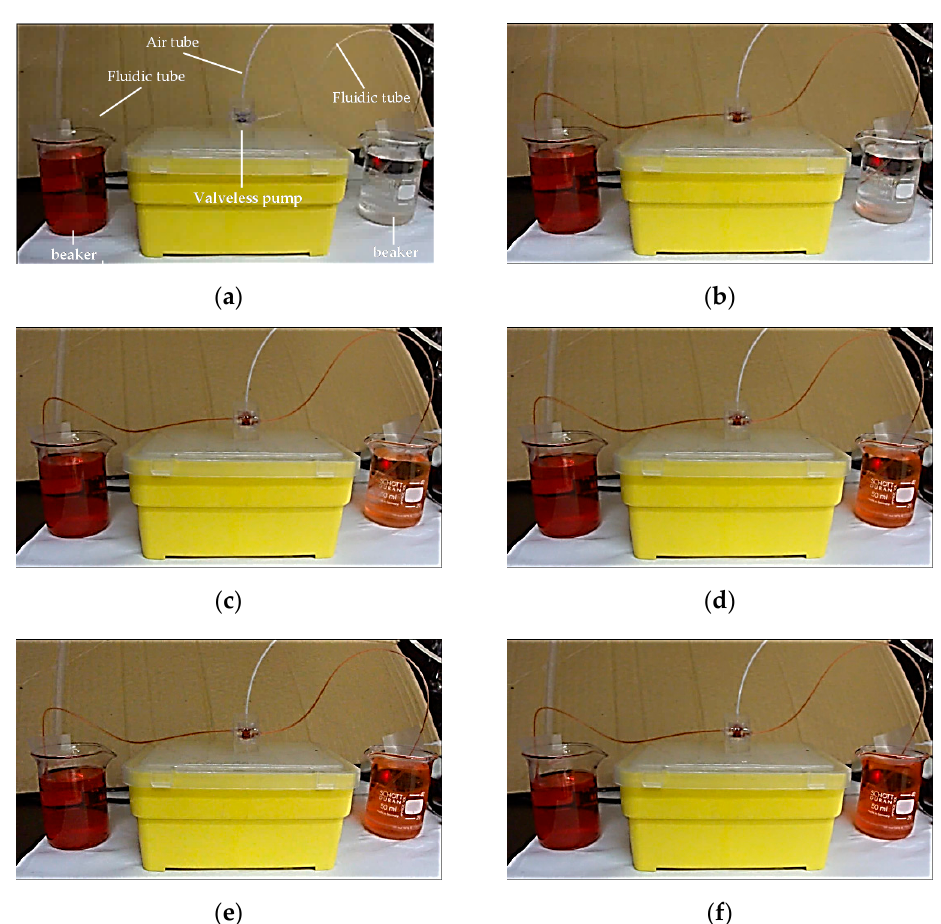
Figure 10. Series of photographs of valveless pump showing pumping performance at different times. ( a ) t = 0 s; ( b ) t = 10 s; ( c ) t = 20 s; ( d ) t = 30 s; ( e ) t = 40 s; and ( f ) t = 60 s.